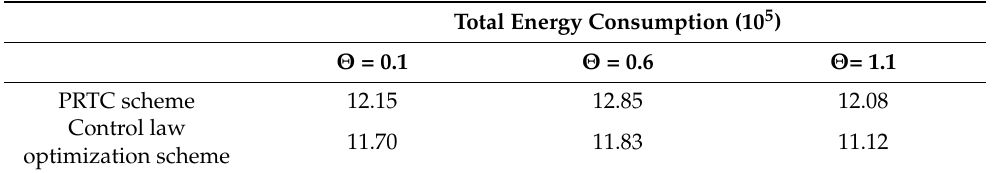
Table 5. Performance of the two schemes in terms of energy